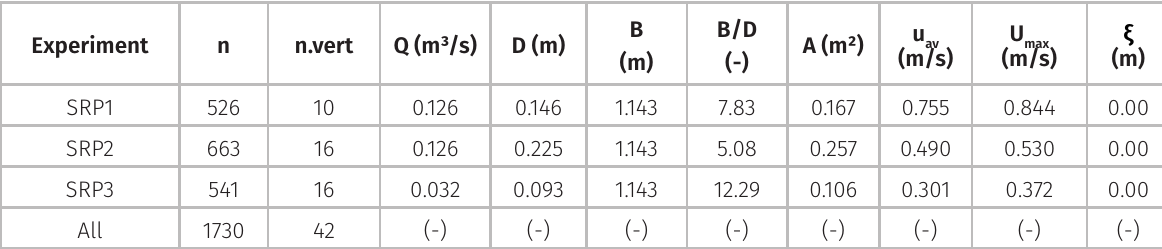
Table I. Parameters of the experiments: run 1 (SRP1), run 2 (SRP2), and run 3 (SRP3). Experiment n